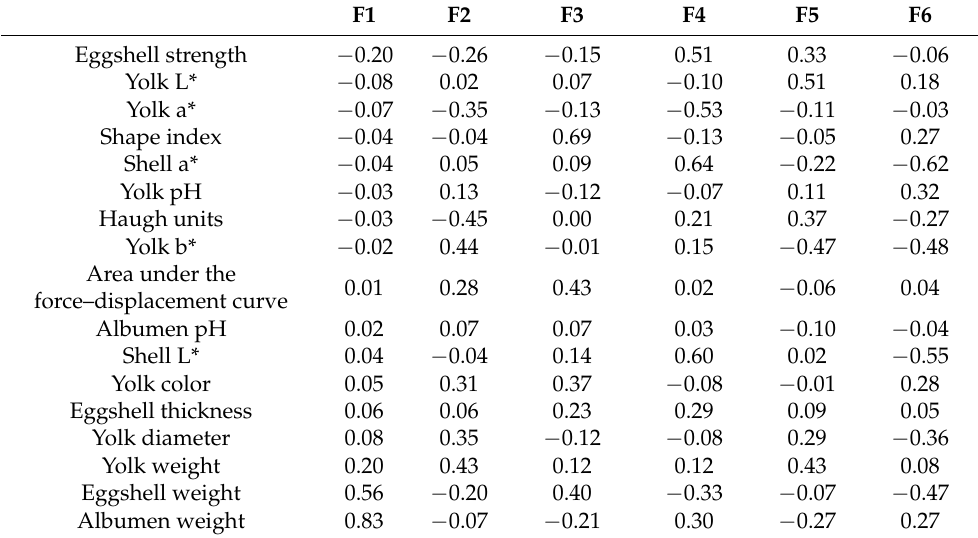
Table 8. Discriminant loadings for external and internal quality–related traits determining the relative weight of each trait on each canonical discriminant